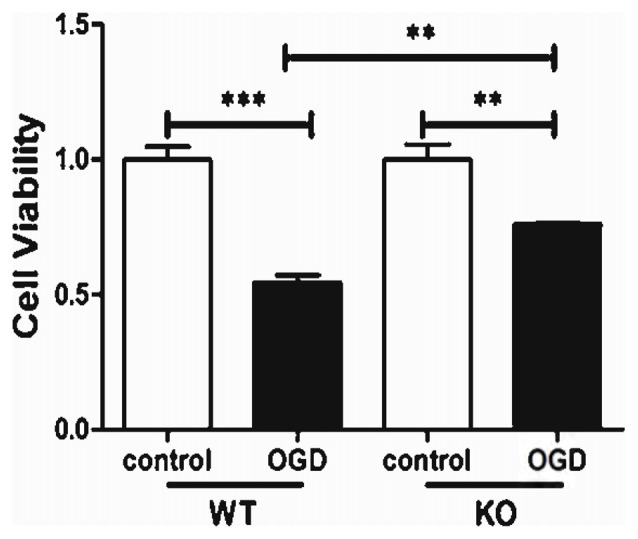
KCa3.1 channel is involved in OGD-induced reduction in viability of astrocytes. Cell viability was determined using the CCK-8 assay. The values represent the fold changes of cell viability induced by OGD. Genetic deletion of the KCa3.1 channel attenuated the decrease in viability of astrocytes after 4 h OGD, compared with WT cells (n = 5). The data are expressed as means ± SEM. **p < 0.01, ***p < 0.001. WT, wild type; KO, knockout; OGD, oxygen–glucose deprivation.